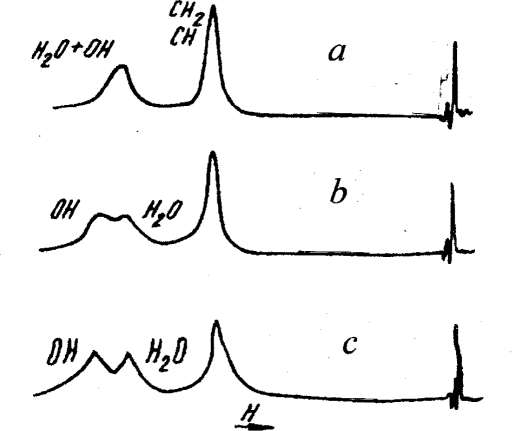
Spectra of 1H – NMR for the water-glycerol solution with the mole concentration x=0.51 of glycerol at different temperatures: a – 308K, b=283K, c–273K, according to [11].